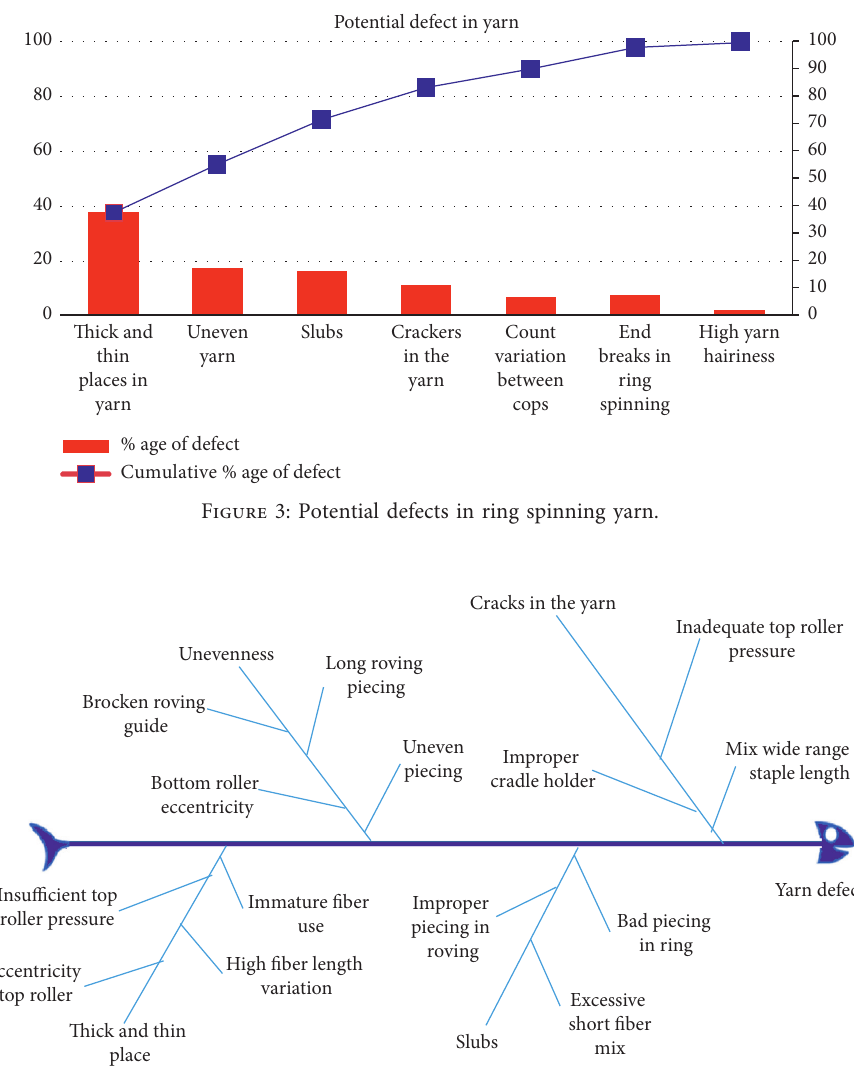
Figure 4: Cause and effect (fishbone) diagram of ring